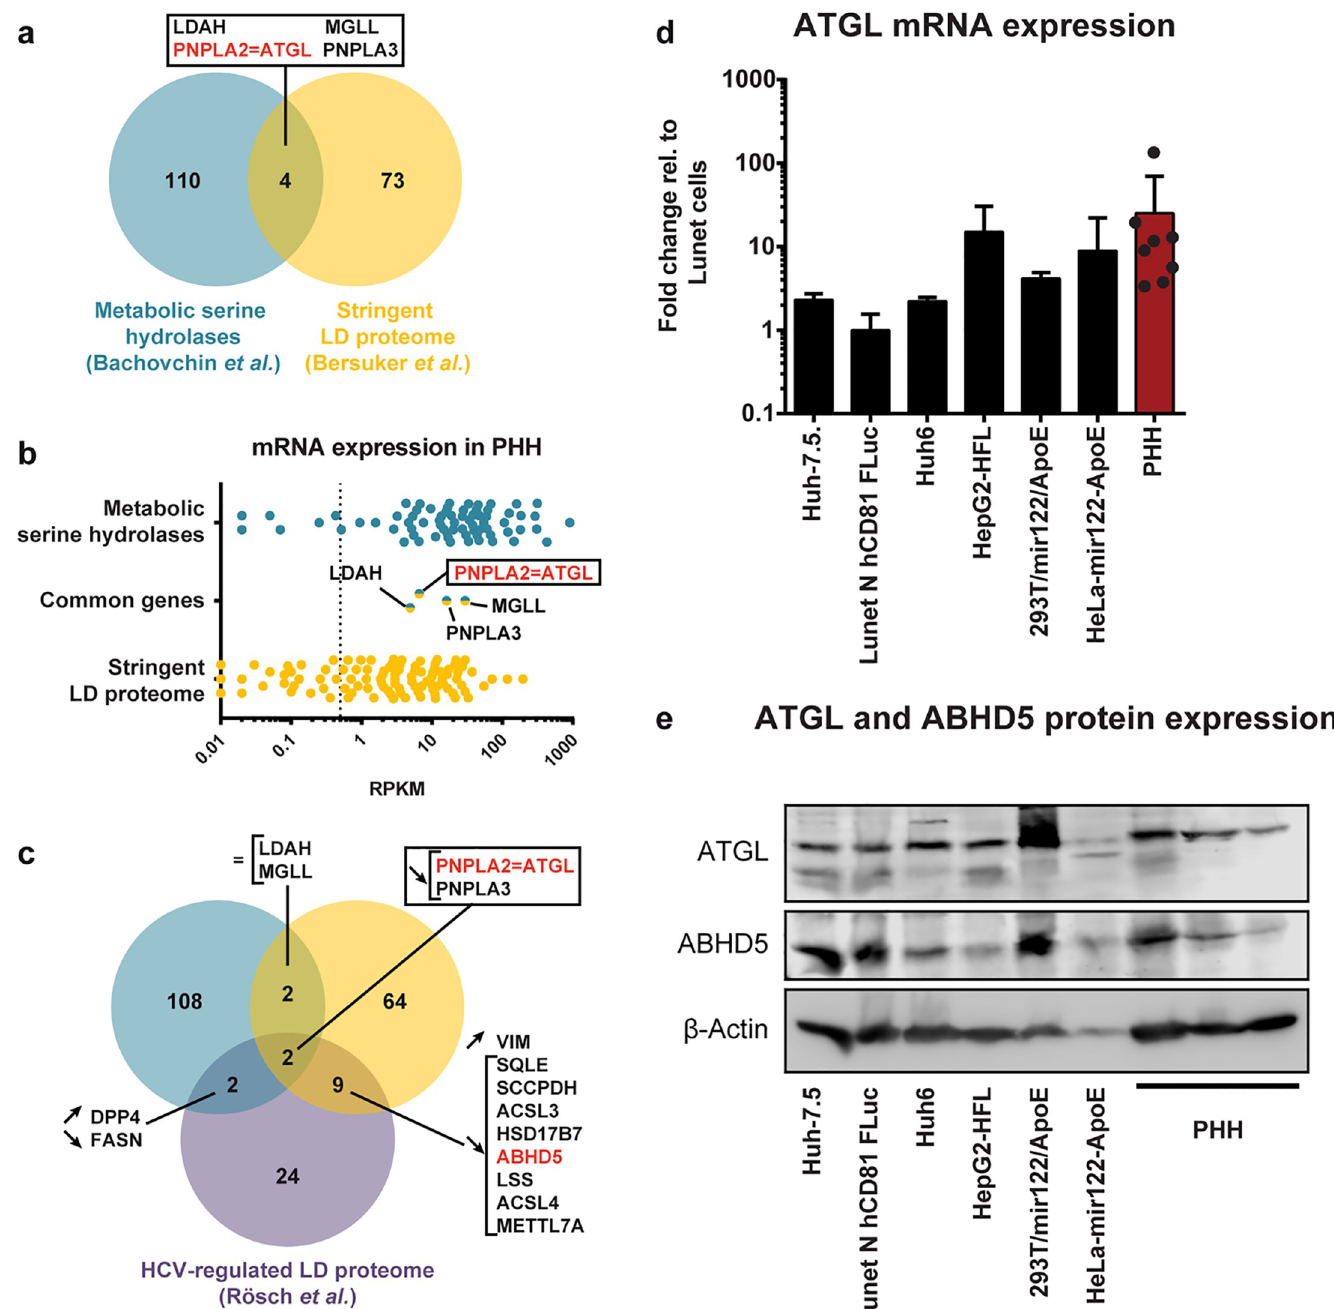
Fig 1. Unbiased search for lipid droplet-associated lipases involved in HCV assembly. ( a ) Venn diagram of metabolic serine hydrolases [32] and the Huh-7 lipid droplet proteome [38]. ( b ) mRNA expression of these genes was determined in primary human hepatocytes (PHHs) from 3 donors by RNA-seq (NCBI database, GEO accession number GSE132548, (Tegtmeyer B, Vieyres G, submitted for publication)). The vertical dotted line indicates an arbitrary expression threshold of 0.5 RPKM (reads per kilobase per million mapped reads). ( c ) Venn diagram depicting the fraction of proteins from (a), whose lipid droplet association varies upon HCV infection according to Ro¨sch et al . [39] (purple circle). Arrows pointing upwards, arrows pointing downwards and the equal sign indicate respectively an increased, decreased or unchanged lipid droplet association upon HCV infection [39]. ( d ) ATGL mRNA expression in a panel of cell lines and in PHHs from 8 individual donors, as determined by qRT-PCR. ( e ) ABHD5 and ATGL protein expression in the same cell lines and in PHHs from 3 random donors.